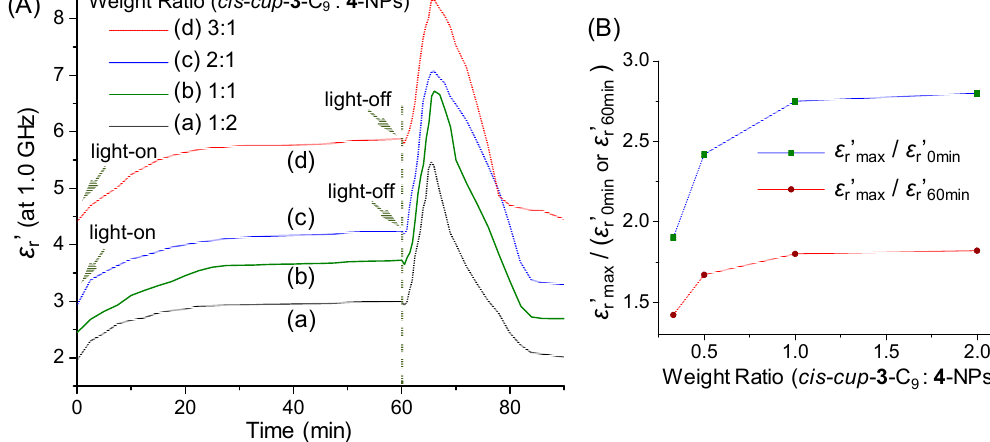
Figure 6. ( A ) Irradiation time ‐ dependent relative dielectric constant ( ε r ’) amplification of trilayered core ‐ shell nanoparticles of ( γ ‐ FeO x @AuNP)@{ cis ‐ cup ‐ tris[C 60 (>DPAF ‐ C 9 )]} n ( 5 ‐ NPs) with a different weight ratio of cis ‐ cup ‐ 3 ‐ C 9 vs γ ‐ FeO x @AuNP ( 4 ‐ NPs) at the frequency of 1.0 GHz with a white LED light irradiation period of 60 min. ( B ) Relative dielectric constant ( ε r ’) ratios of the values at peak maximum vs that at either 0 min or 60 min, showing a progressive increase of the degree of dielectric amplification.